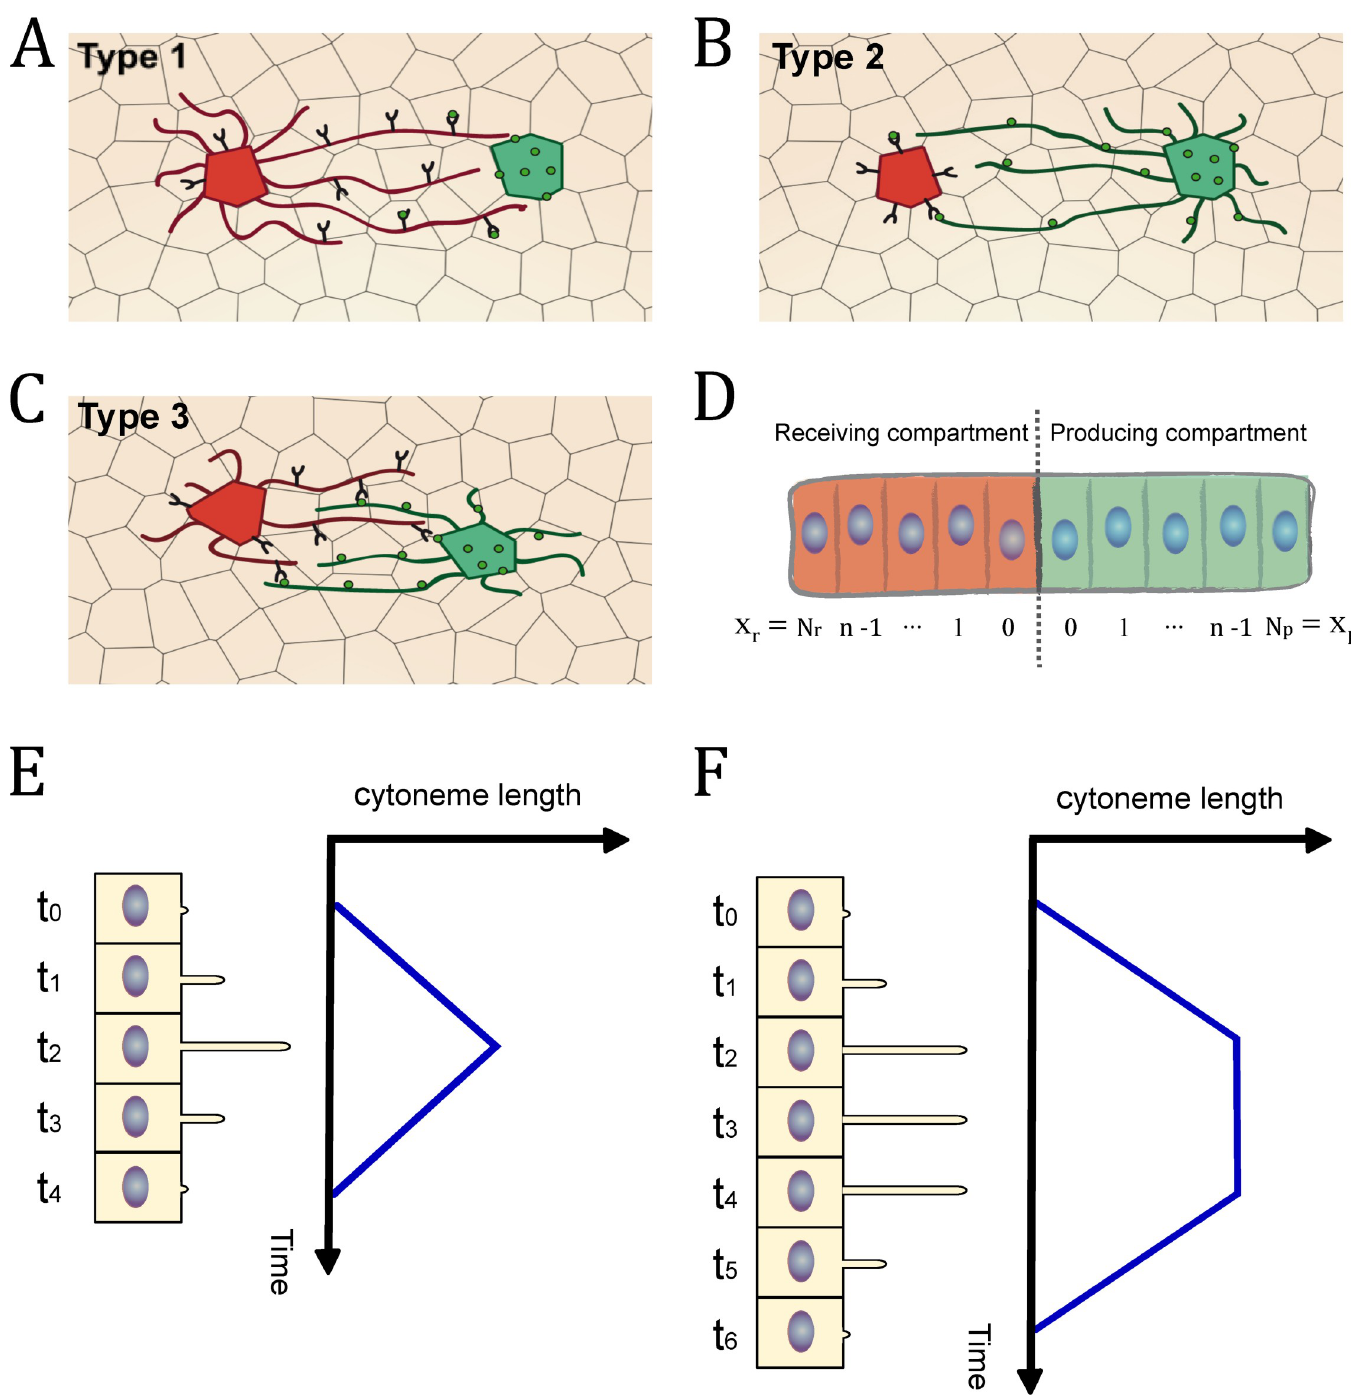
Fig 1. Schemes of cytoneme-mediated cell signaling based on experimental evidence : (A) Type 1: Receiving cells emit cytonemes to collect the morphogen from producing cells. (B) Type 2: Producing cells emit cytonemes to deliver the morphogen to receiving cells. (C) Type 3: Both producing and receiving cells emit cytonemes to deliver and collet the morphogen respectively. (D) Frame of reference used to develop the mathematical equations. (E) Schematic representation of the cytoneme triangular dynamics. (F) Schematic representation of the cytoneme trapezoidal dynamics.